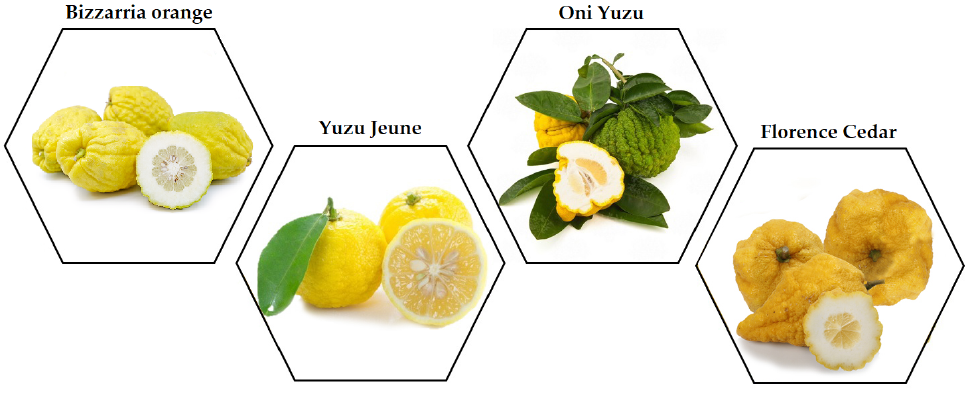
Figure 1. Images of Citrus species investigated.